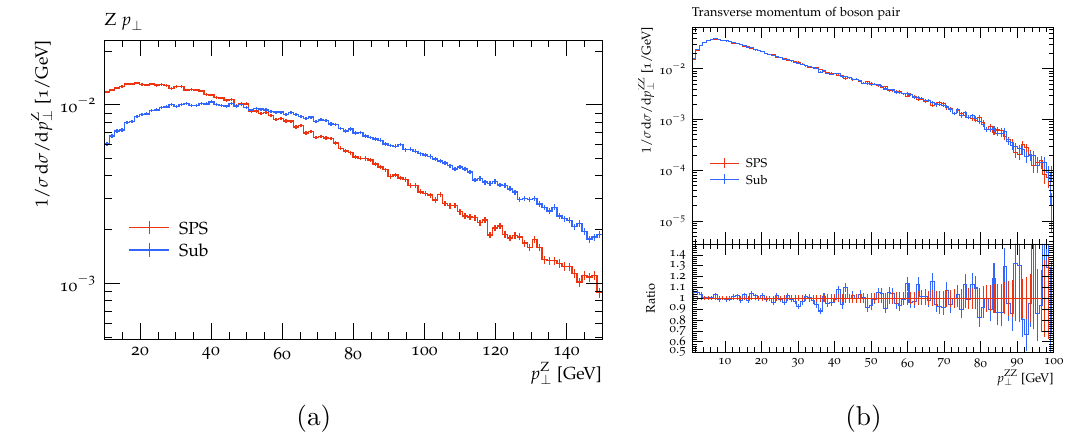
Figure 8 . (a) Transverse momenta of the Z 0 bosons and (b) transverse momentum of the Z 0 Z 0 pair as produced by the SPS and subtraction terms. The momentum fractions X are set to be equal to the pre-kick fractions and (cid:22) = M Z . The SPS setup is the reference in the ratio plots. The histograms are normalised to